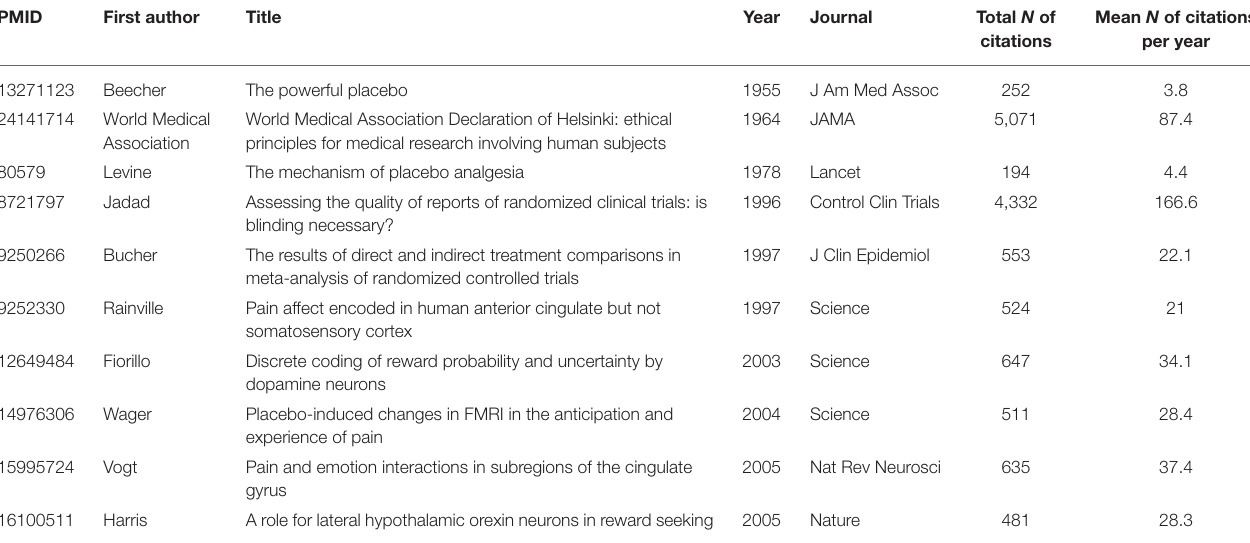
TABLE 1 | Articles with highest age/citation